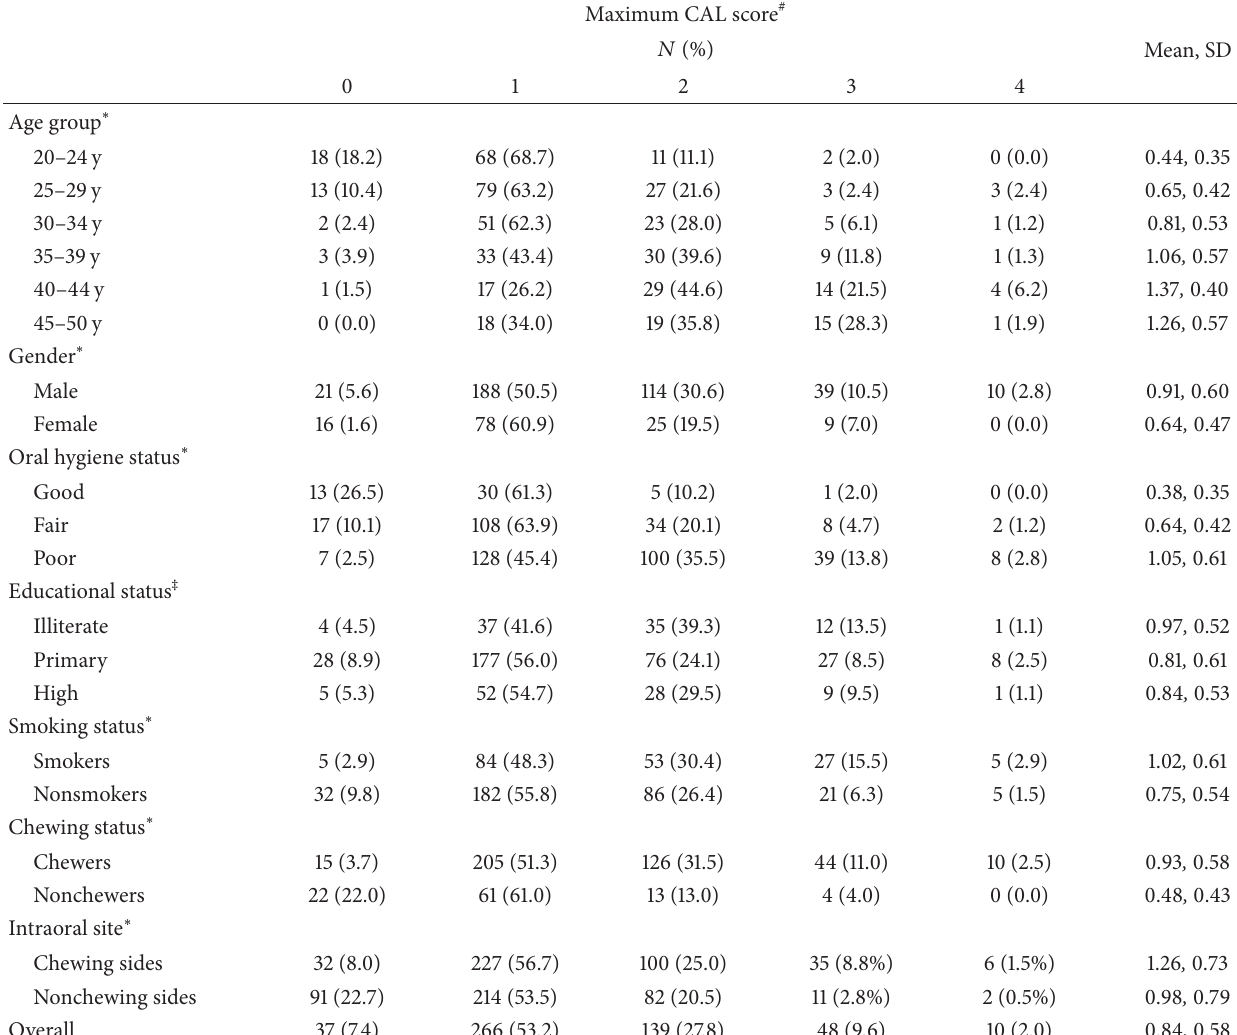
Table 3: Descriptive statistics of CAL by risk factors.